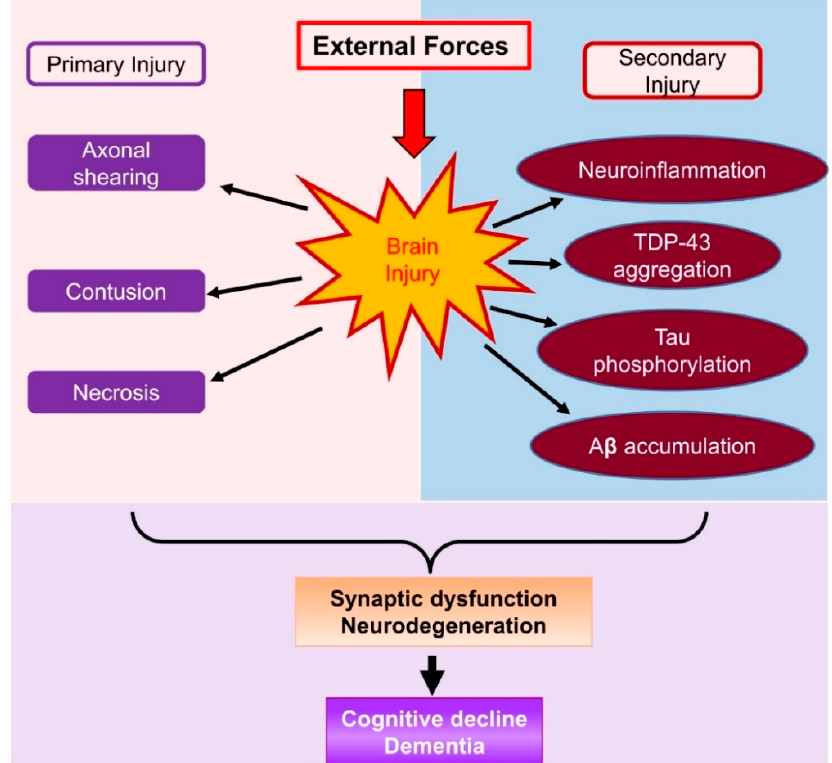
Figure 1. A schematic representation of brain damage following TBI, which causes primary injury and secondary injury. Primary injury occurs immediately after TBI, and secondary injury is initiated from minutes to hours following TBI. Secondary injury involves a cascade of pathophysiological processes including neuroinflammatory responses, tau phosphorylation, TDP-43 aggregation, and A β accumulation. These neuropathological changes following TBI lead to neurodegeneration, synaptic dysfunction, and cognitive decline.